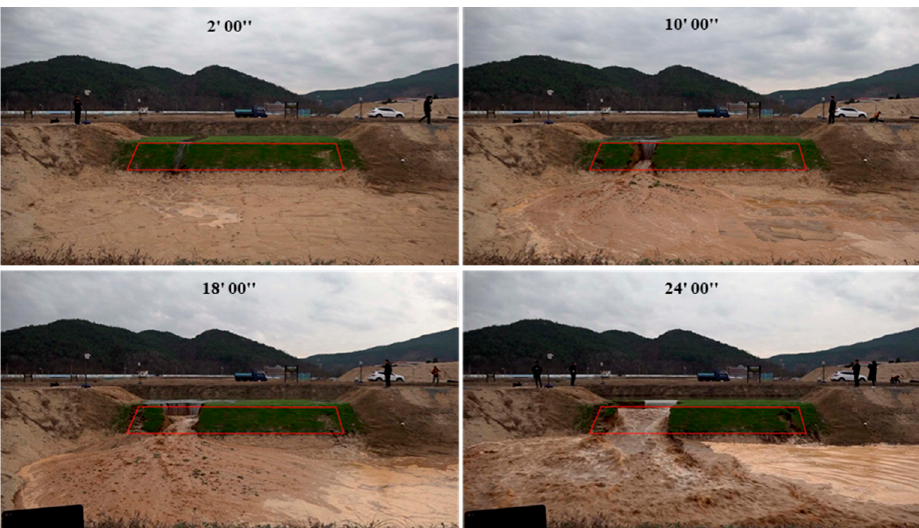
Figure 10. Levee collapse pattern over time immediately after overtopping (Case 3).